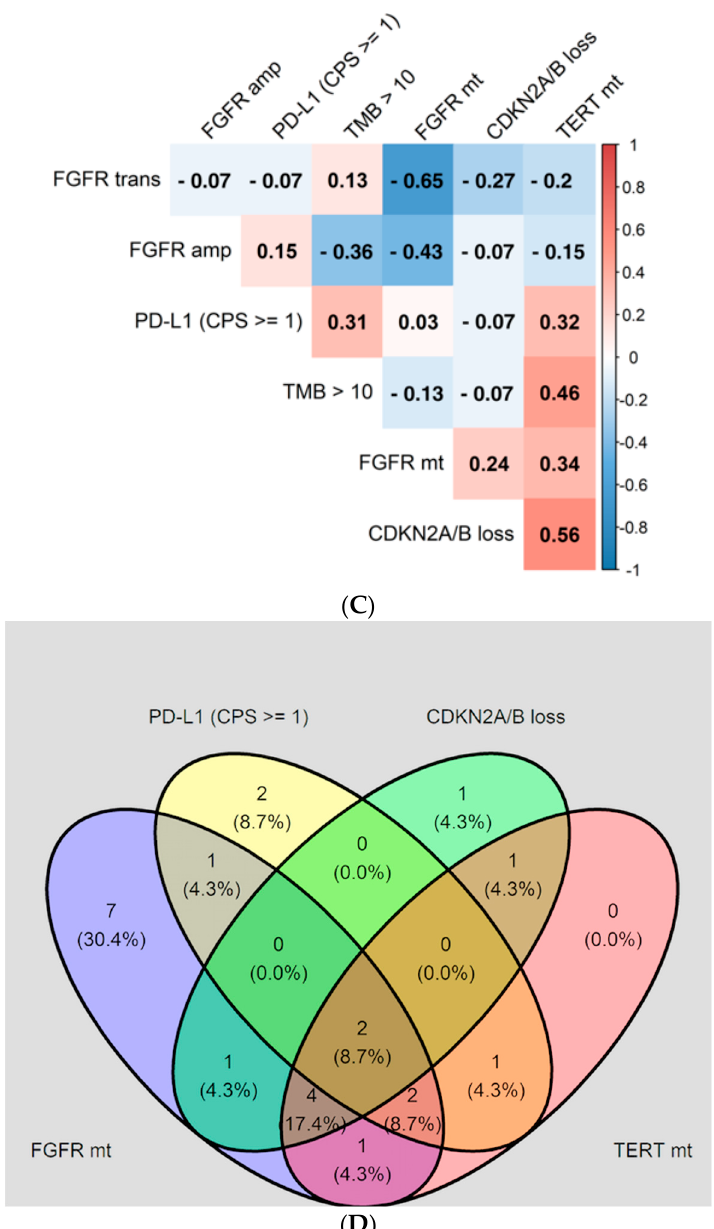
Figure 2. ( A ) PFS or OS according to the type of FGFR genomic alteration: translocation/fusion ( Trans) and amplification (Amp) cases were added. ( B ) Overall survival according to additional biomarkers: ( a ) CDKN2A/B loss; ( b ) TERT promoter mutations; ( c ) PD-L1 (CPS < 1 vs. CPS ≥ 1); ( d ) TMB ( ≤ 10 vs. >10). ( C ) Phi coefficient assessing the correlation between different biomarkers in the FGFR GA population. Phi correlation. Heat map: the phi index ranges from − 1 to +1; red indicates a positive correlation (darker red indicates a stronger correlation between two biomarkers); blue indicates a negative correlation; white (phi = 0) represents no correlation. ( D ) Venn diagram representing the superposition of the expression of different biomarkers: expression of PD-L1 ≥ 1, FRGR genomic alterations, loss of cyclin-dependent kinase inhibitor (CDKN2A/B), and TERT promoter mutation.